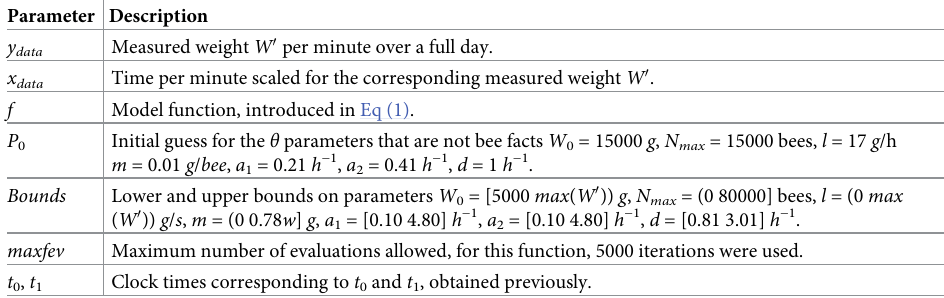
Table 3. The inputs required for the “scipy.optimize.curve_fit” Pythons’ function. Parameter Description y data Measured weight W 0 per minute over a full